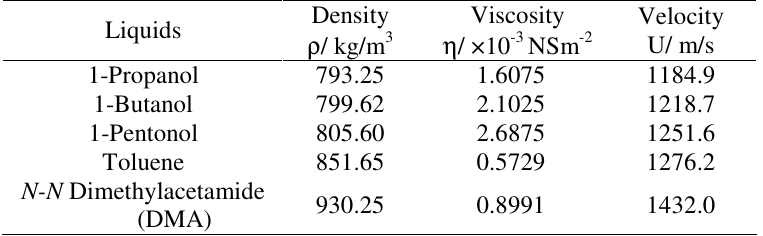
Table 1. Density ( ρ ), viscosity ( η ) and Ultrasonic velocity (U) of pure